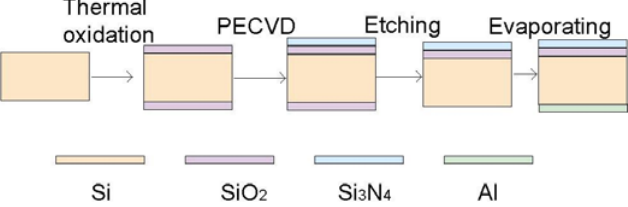
/Si N . Fabrication of LAPS 2 3 4